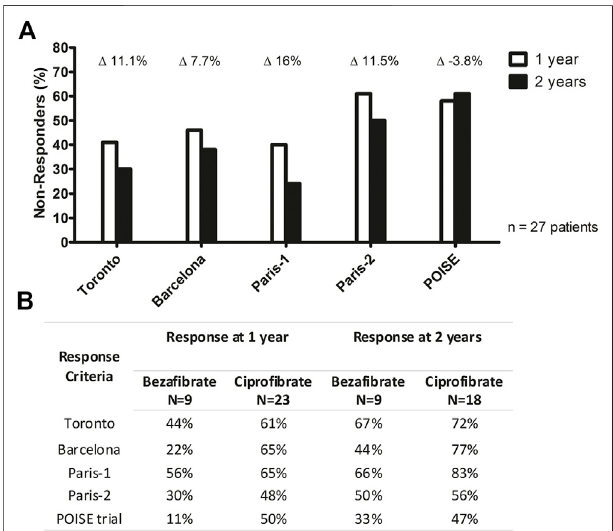
FIGURE 1 | (A) Paired biochemical global response rate strati fi ed by different criteria1 and 2 years after associating fi brates to UDCA. Deltas show the percentage response gain between 1 and 2 years of treatment. (B) Comparison between beza fi brate and cipro fi brate response to treatmentaccordingtodifferentcriteria1and2yearsafterassociating fi brates to UDCA.